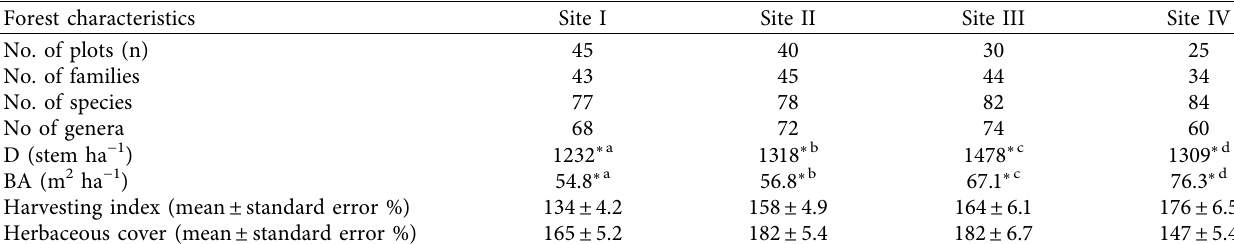
Table 5: Stand characteristics of woody species and analysis of variance in four study sites.